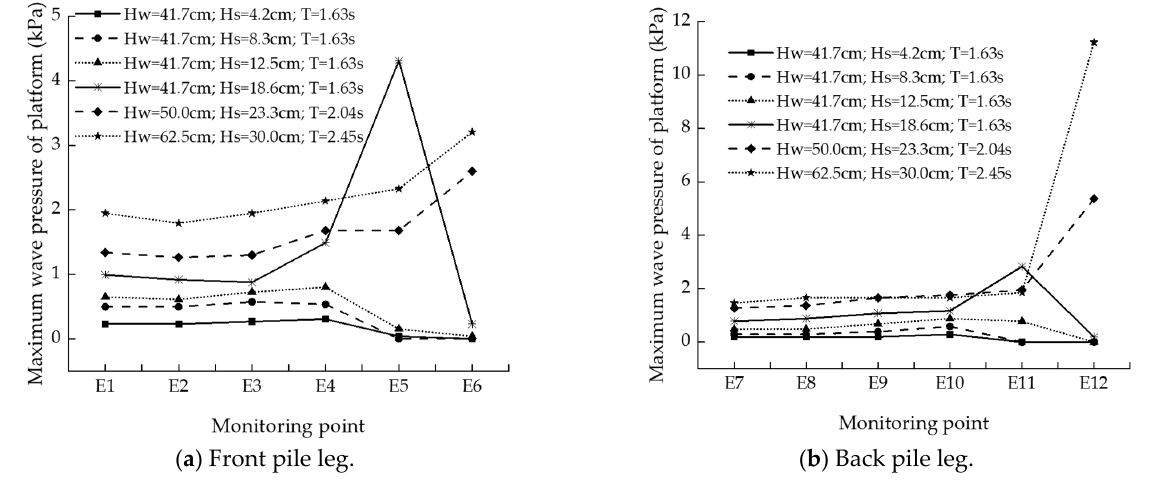
Figure 7. Diagram of wave pressure at different positions on the pile.